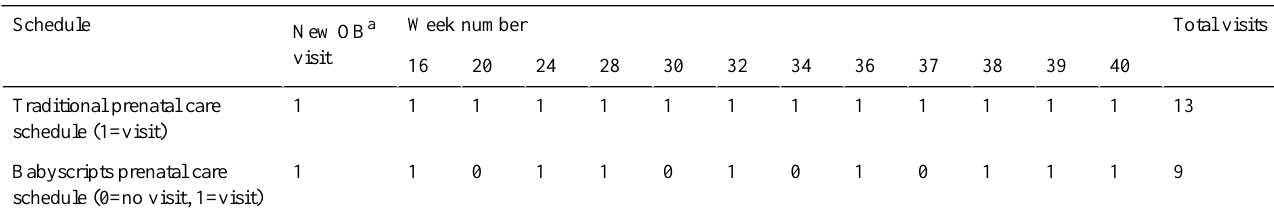
Table 1. Sample alternative prenatal care schedules.